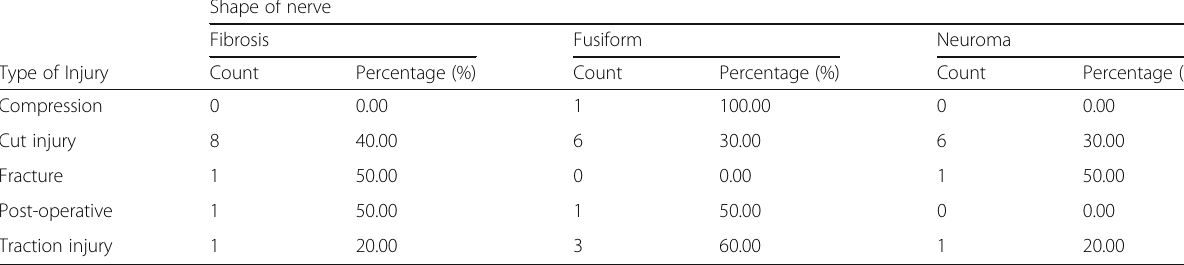
Table 4 Type of injury and shape of the injured nerve by ultrasound